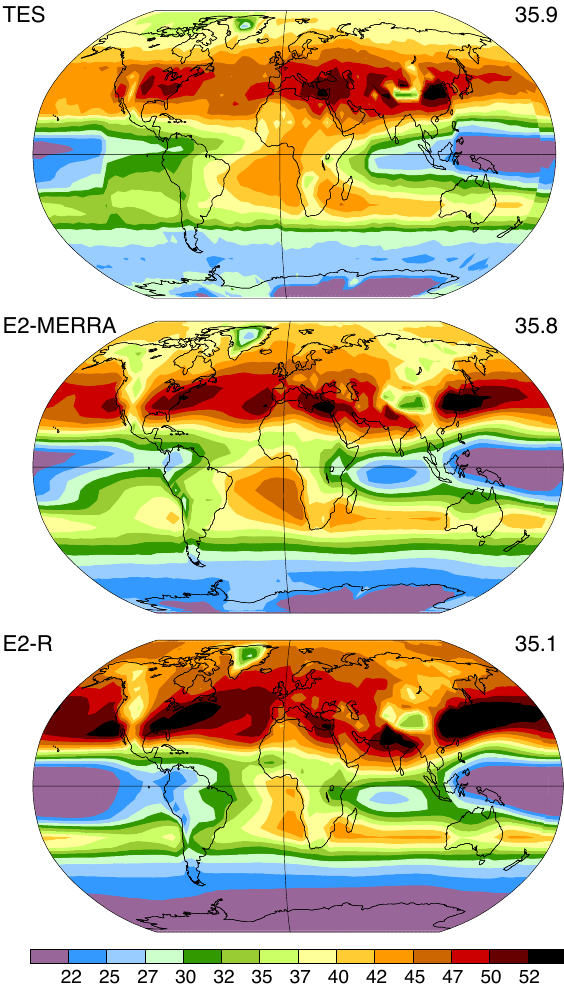
Fig. 4. Annual average 2005–2009 tropospheric ozone column (DU) in the indicated observations and models. The tropopause is defined using the NCEP 2005–2009 monthly values for TES and the model’s internally calculated values. Global mean values are in the upper right.